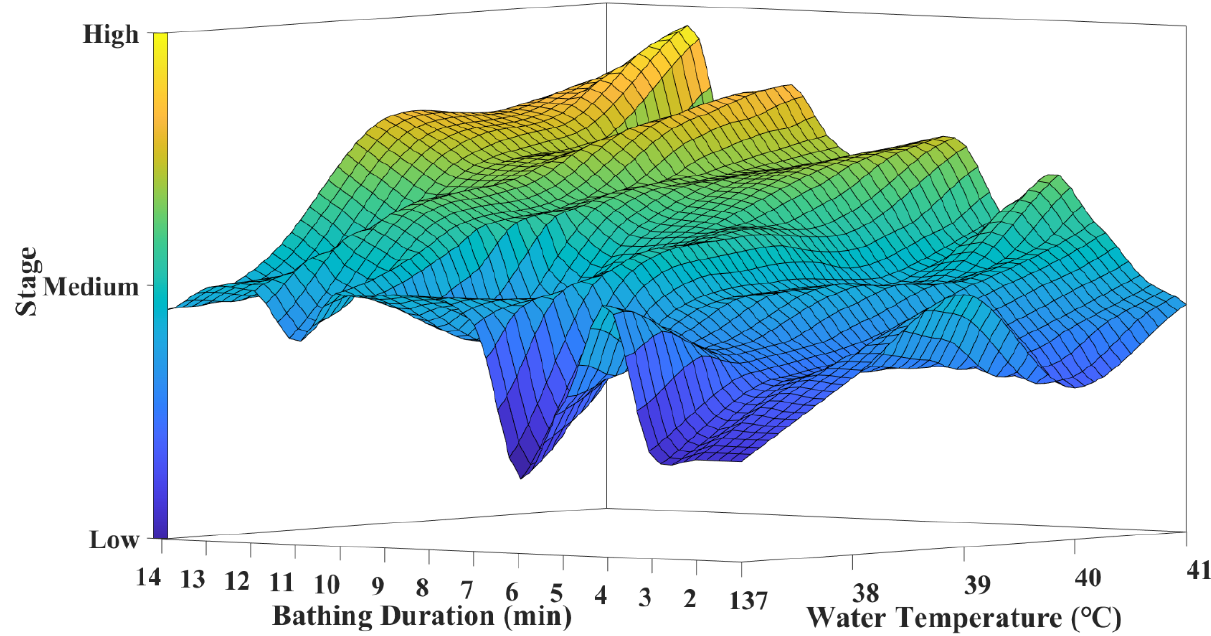
Figure 8. Relationship surface between water temperature, bathing duration, and the equivalent EST stage in terms of HRV behaviors.